Question: What visual encoding does this figure use to show its data?
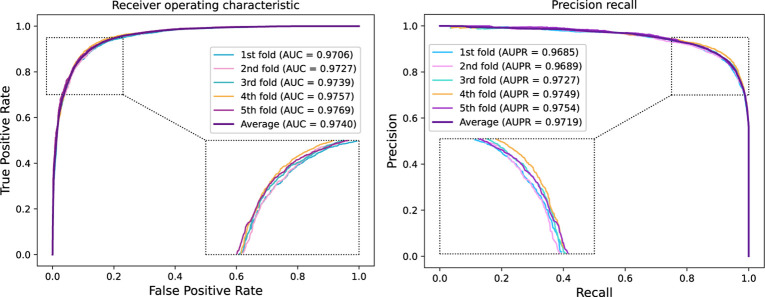
Answer: line